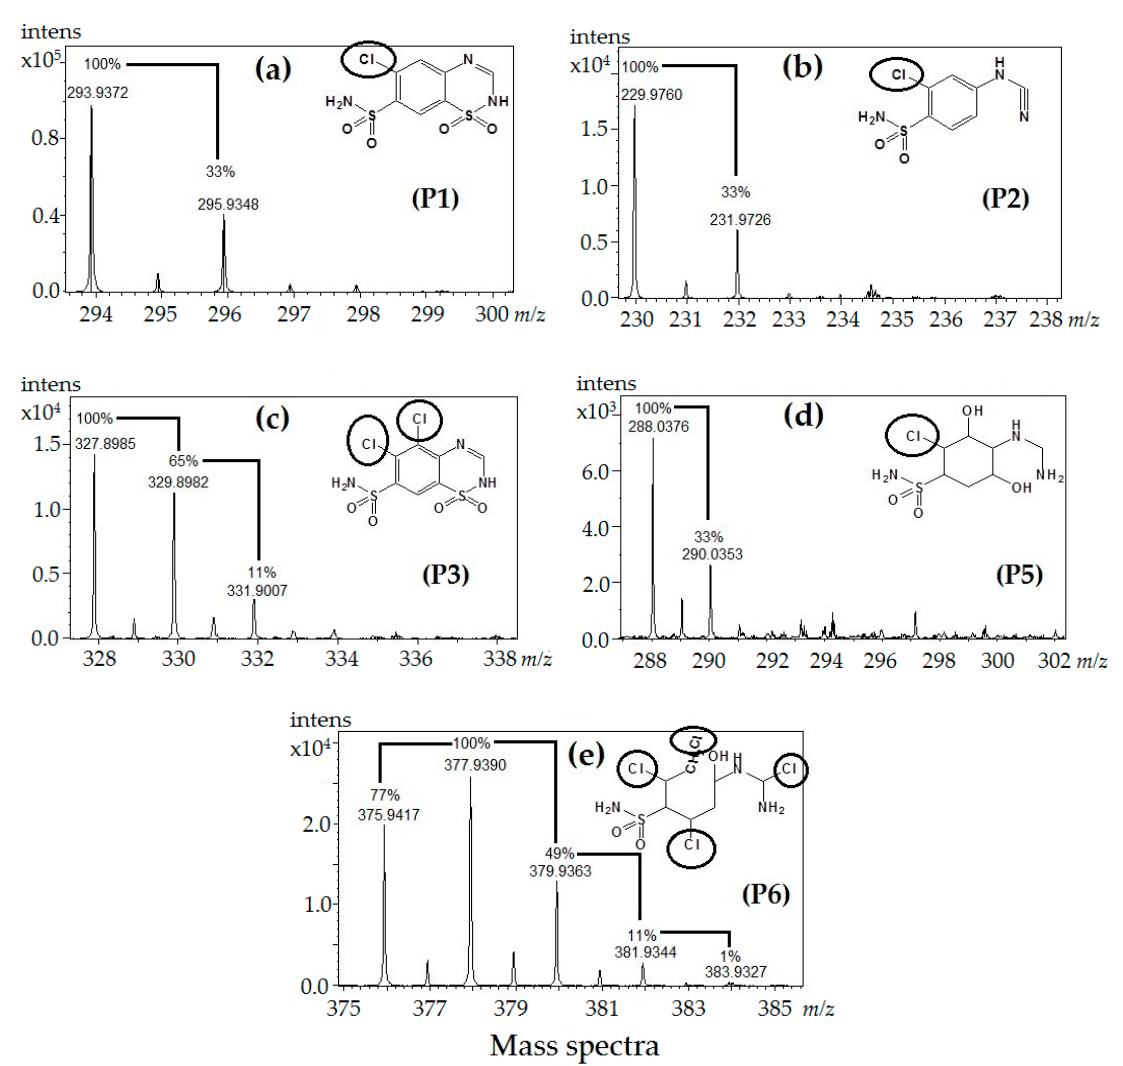
Figure 4. Elucidation profile of the chlorinated by-products during electrochemical oxidation process of HDZ; ( a , b , d ) mono-chlorine atoms; ( c ) di-chlorine at oms; ( e ) tetra-chlorine atoms.